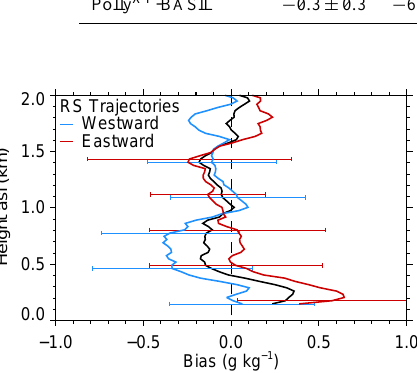
00:40 UTC. The white area indicates regions inside or above clouds without any water vapour information. The cloud base was determined by the gradient method on the range- corrected signal at 1064 nm (Baars et al., 2008). The green marked profiles until 01:20 UTC are calibrated with the IWV method, whereas the red marked after 01:20 UTC indicate cloudy conditions. These profiles are calibrated using the av- eraged calibration factor of the last 20 min clear sky inter- val (01:00 to 01:20 UTC). Both profiles of the water vapour mixing ratio at 01:00 and 02:20 UTC are in a good